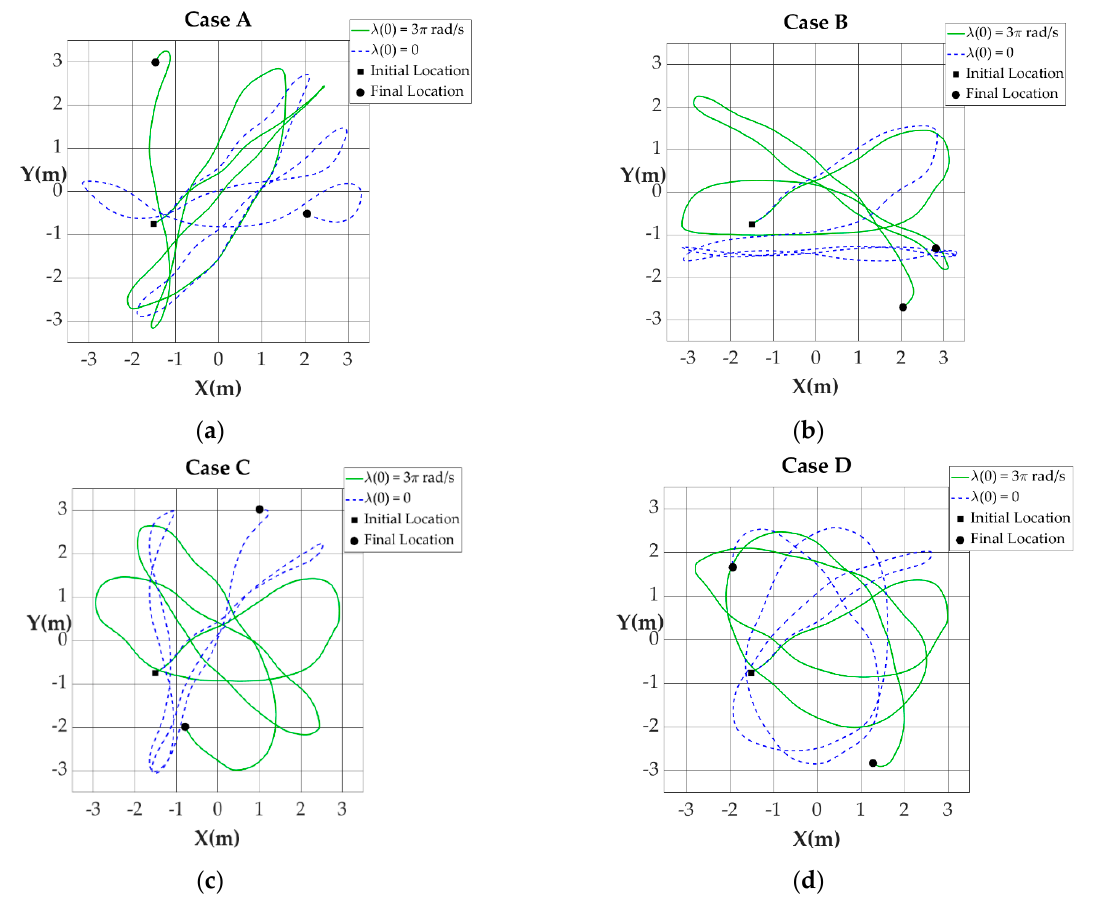
Figure 8. Comparison of the path taken by the point of contact P projected on the XY plane when λ ( 0 ) = 3 π rad / s (solid green line) and when λ ( 0 ) = 0 (dashed blue line) for ( a ) Case A, ( b ) Case B, ( c ) Case C, ( d ) Case D.